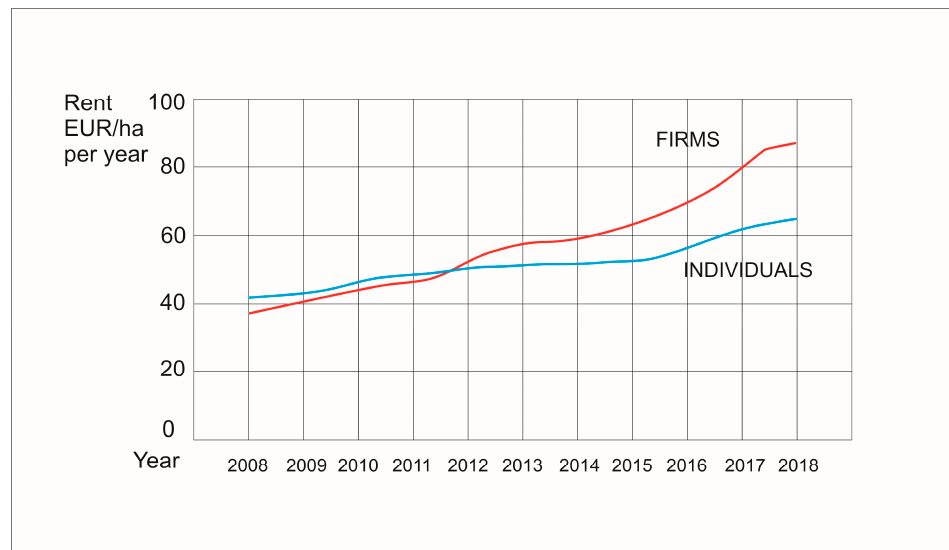
Figure 2. Rent of farm land in the Czech Republic (2008–2018) for firms and individuals.